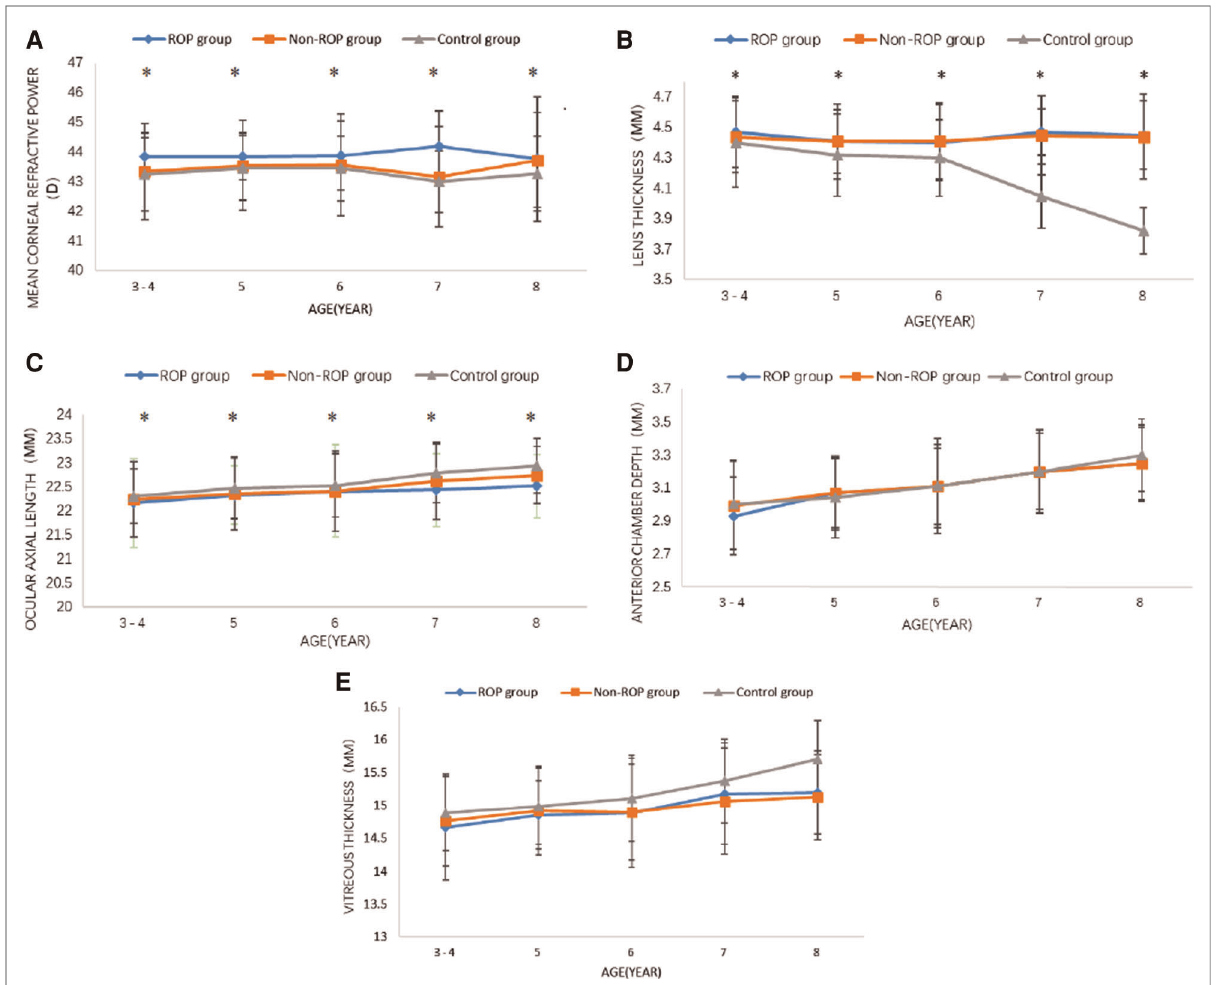
FIGURE 2 Changes in the optical components at 3 – 8 years old. ( A ) Corneal refractive power, ( B ) lens thickness, ( C ) ocular axial length, ( D ) anterior chamber depth, ( E ) vitreous thickness. ROP=retinopathy of prematurity; MM=millimetre; D=diopter. * P <0.05 (one-way analysis of variance, least- signi fi cant